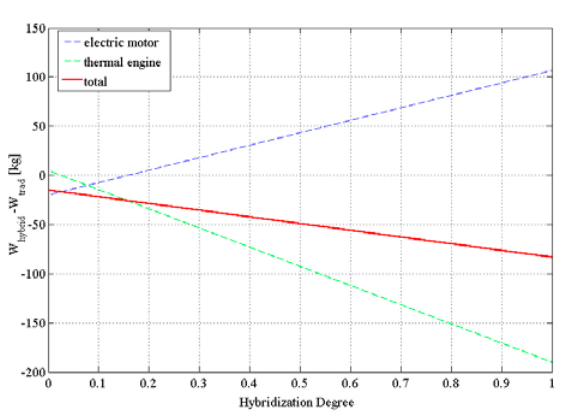
Fig. 16. Thermal engine and electric motor trends as functions of the hybridisation